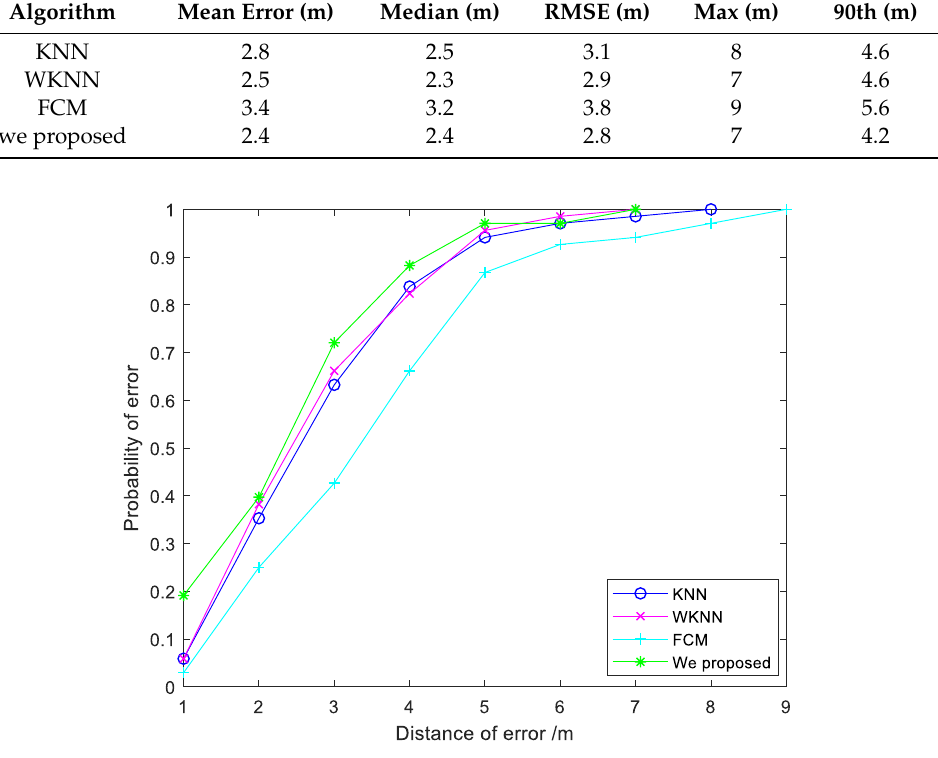
Figure 13. Comparison of positioning error in terms of CDF.